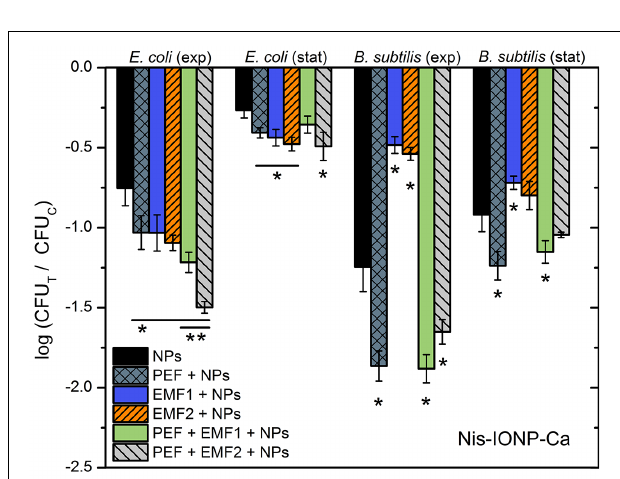
FIGURE 6 | Inactivation of E. coli and B. subtilis using different treatment protocols and nisin-loaded iron oxide NP with Ca as a capping agent (Nis-IONP-Ca), where PEF – 10 kV cm − 1 × 8 × 100 µ s; EMF1 – 3.3 T × 50, 0.25 Hz; EMF2 – 10 mT, 100 kHz, 2 min. The number of residual culturable cells in the samples after the PEF treatment (CFU T ) was compared with ones in the control samples without treatment (CFU C ). The asterisk ( ∗ ) represents statistically significant ( P < 0.05) difference versus NPs only treatment. The asterisk ( ∗∗ ) represents statistically significant ( P < 0.05) difference versus PEF + NPs